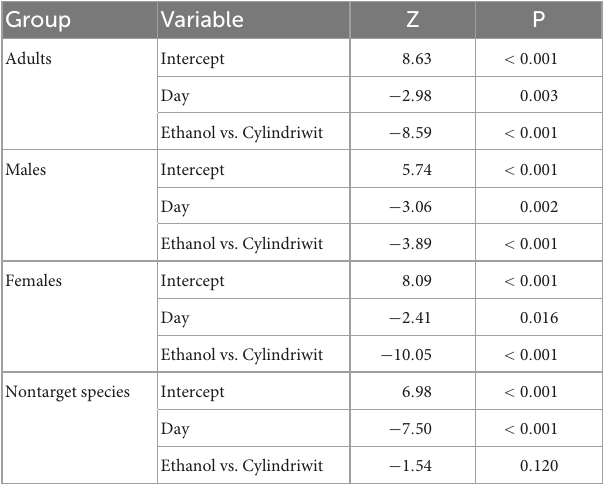
TABLE 5 Results of the trapping success analyses among years using the pheromone of the oak pinhole borer in the Czechia.